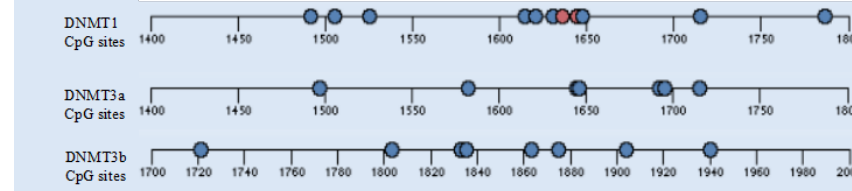
Figure 7. Gene structures of detected promoter region of DNMT1 , DNMT3a and DNMT3b . Locations of CpG sites in this study indicated in blue were analyzed, whereas those indicated in red were either not uniquely discriminated in the spectra or had low call rates.